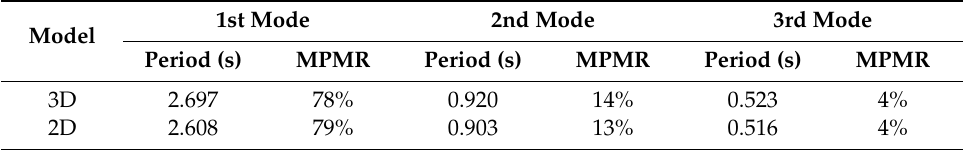
Figure 5. Analytical model of the SC-TOBFs: ( a ) 3D model and ( b ) 2D model. Table 2. Modal analysis comparison.